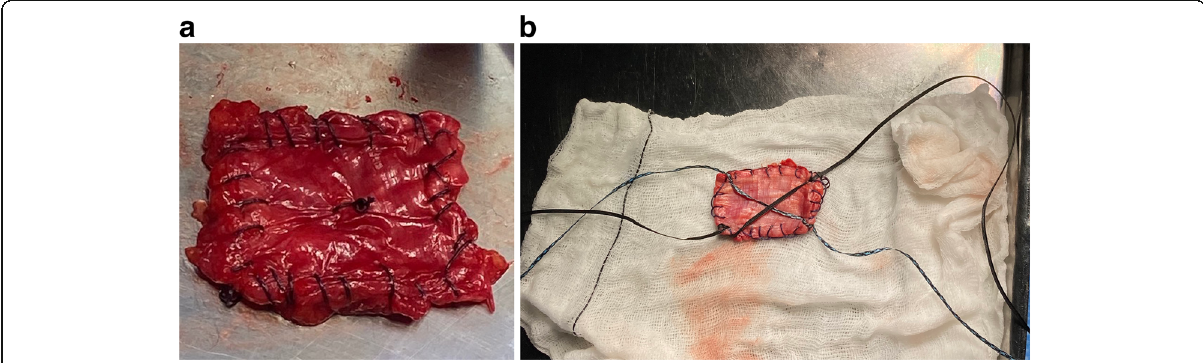
Fig. 2 a Final prepared graft should be approximately 4 × 3 cm in size, with variable thickness. Thickness of the graft is greater when harvested more proximally. b A crossed suture tape configuration with “ lasso-loop ” knots at each corner is created by passing two BroadBand Tapes (ZimmerBiomet, Warsaw, IN, USA) from corner to corner sequentially, using a Quattro Suture Passer (ZimmerBiomet). The suture tapes are therefore locked to the graft corners, keeping it spread wide open when held under